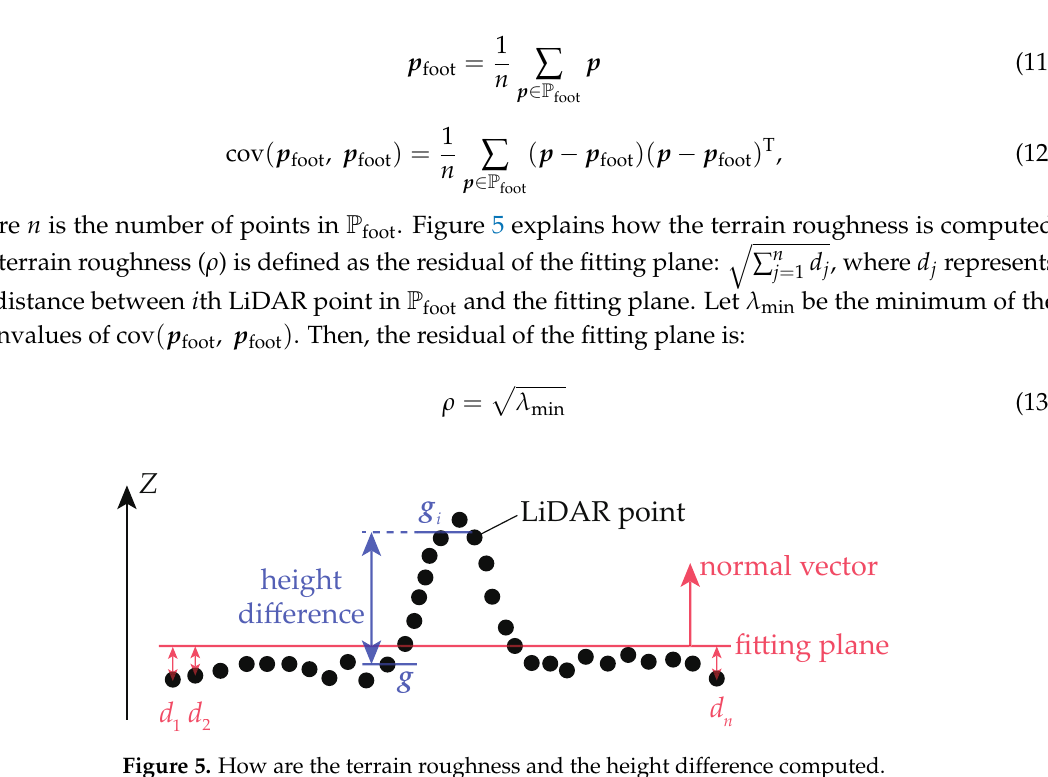
Figure 5. How are the terrain roughness and the height difference